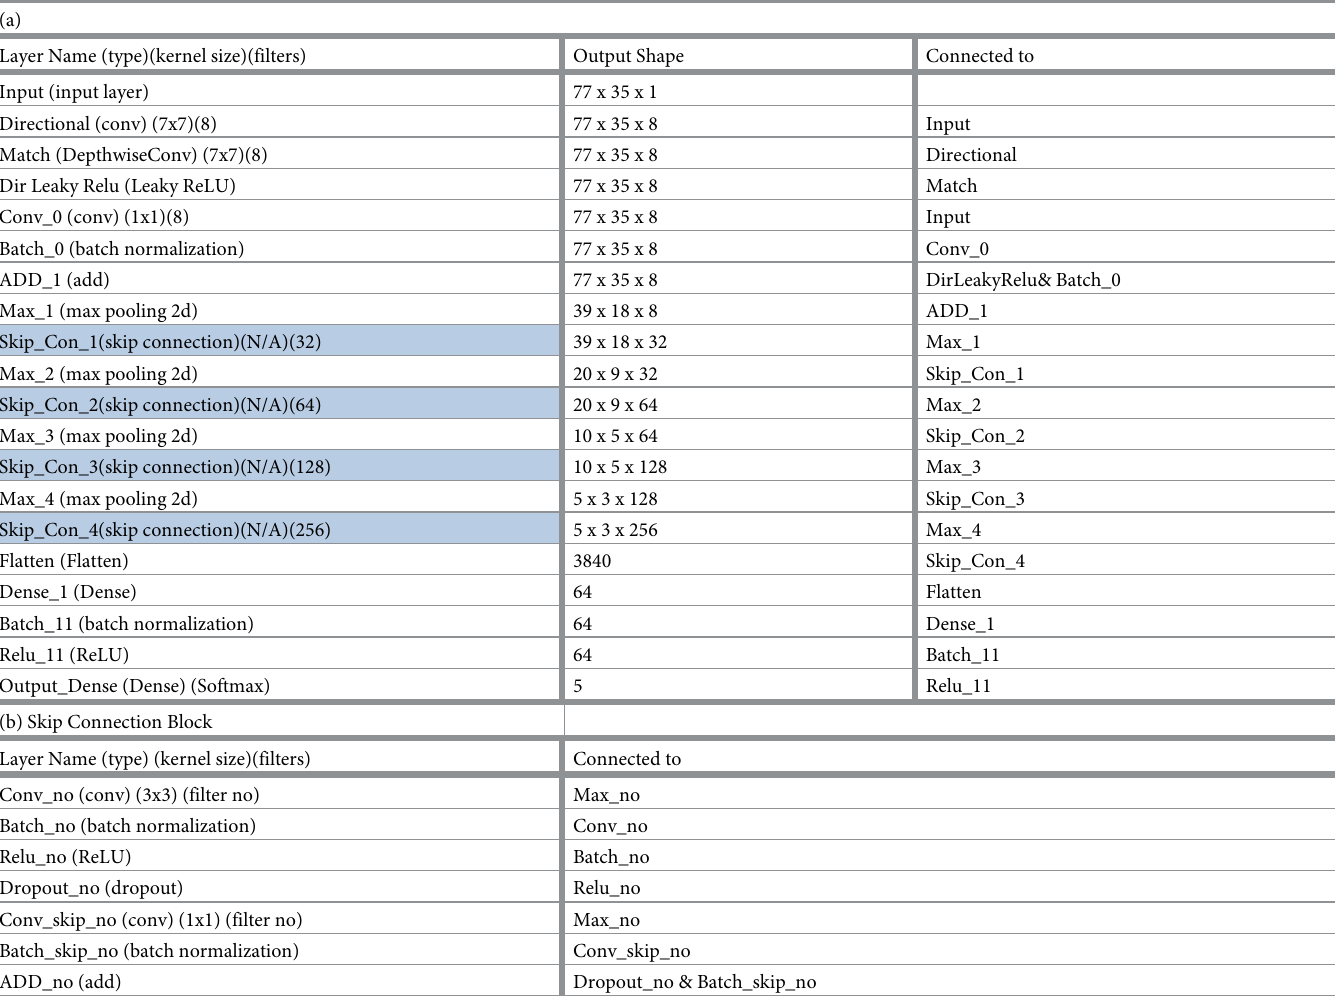
Table 1. (a) The architecture of our CNN with Directional Filter (CNNDF) layer, and (b) details of the skip connection block.